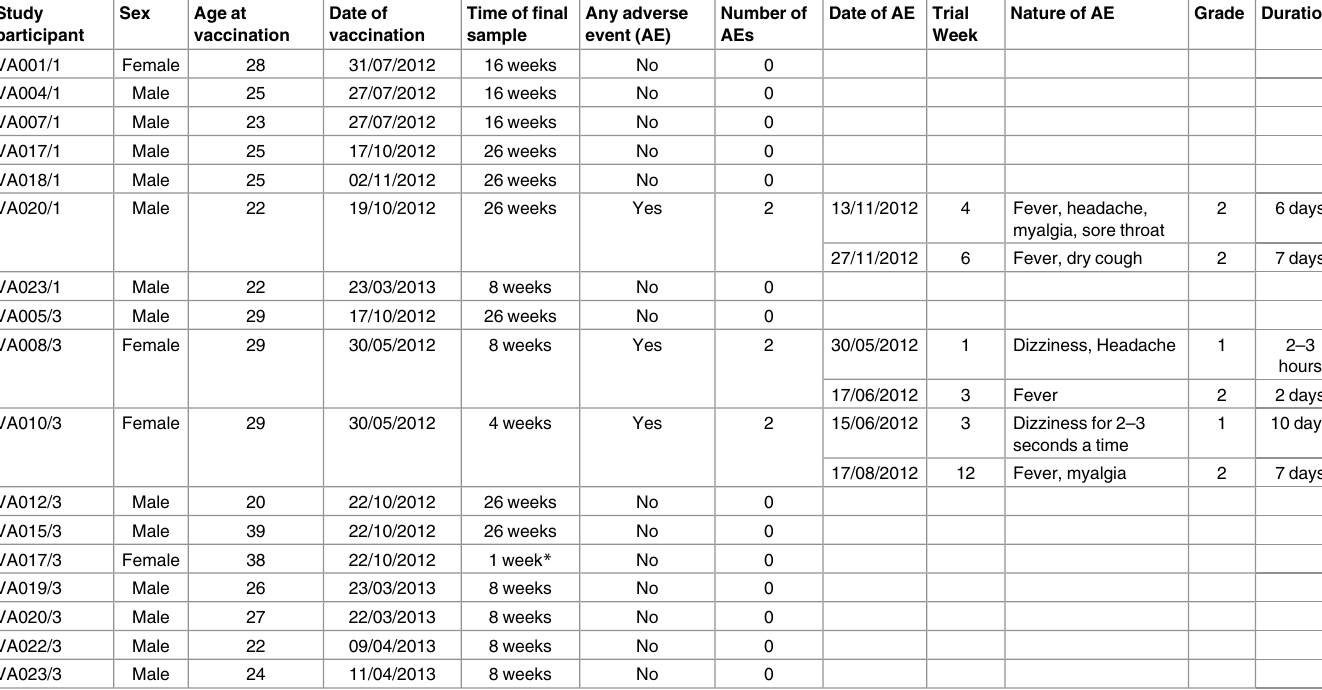
Table 1. Characteristics of the participants and adversereactions to live JE vaccine SA14-14-2.